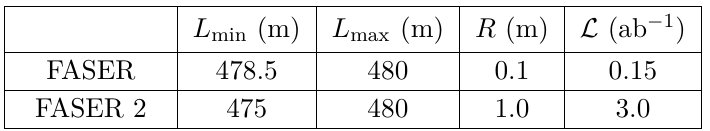
Table 1 . Dimension of the FASER detector and integrated luminosity used for this study. L min and L max are the distance to the front and rear end of the FASER detector from the IP, respectively. R is detector radius, respectively. L is the integrated